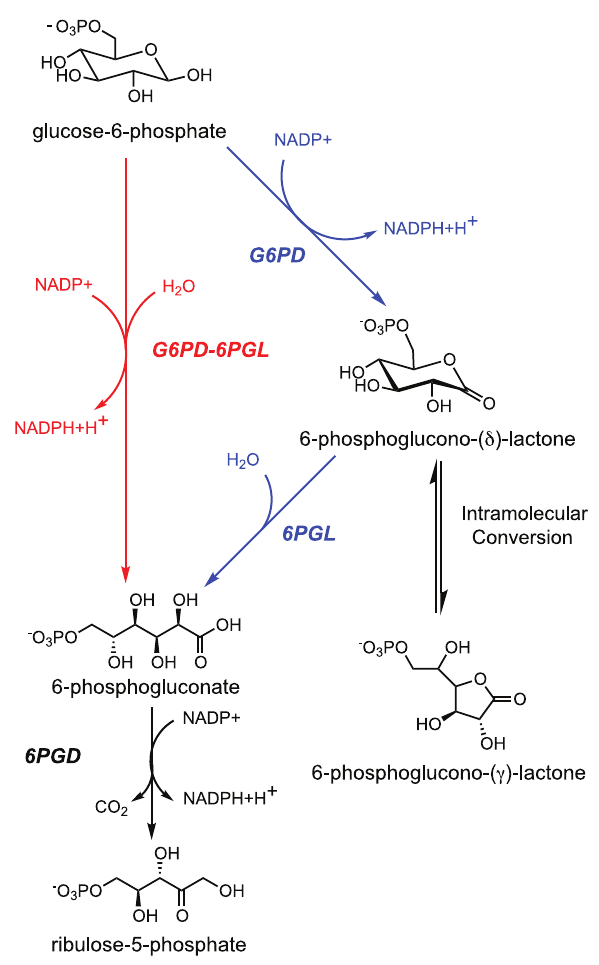
Figure 1. The oxidative branch of the pentose phosphate pathway. The route taken by organisms with bifunctional enzymes is shown in red, while the route taken by other organisms with a functioning pentose phosphate pathway is shown in